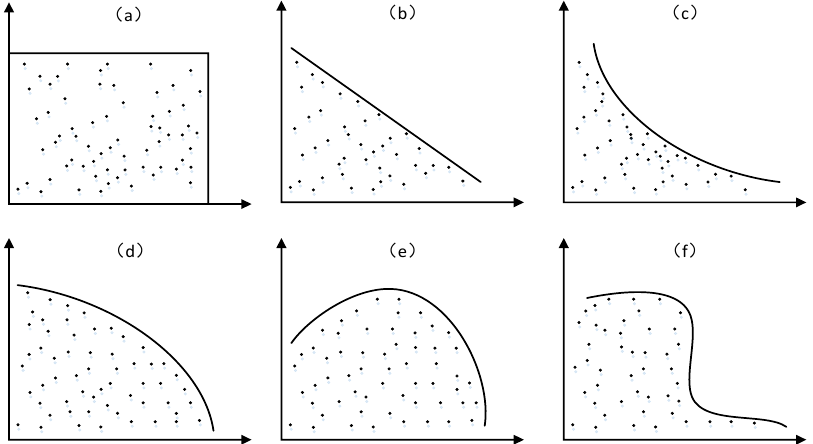
Figure 2. Six forms of the trade-off relationship for ecosystem services: the independent ( a ), linear ( b ), convex-curve ( c ), concave-curve ( d ), non-monotonic concave-curve model ( e ), and reverse ‘S’-type curve ( f ) models.